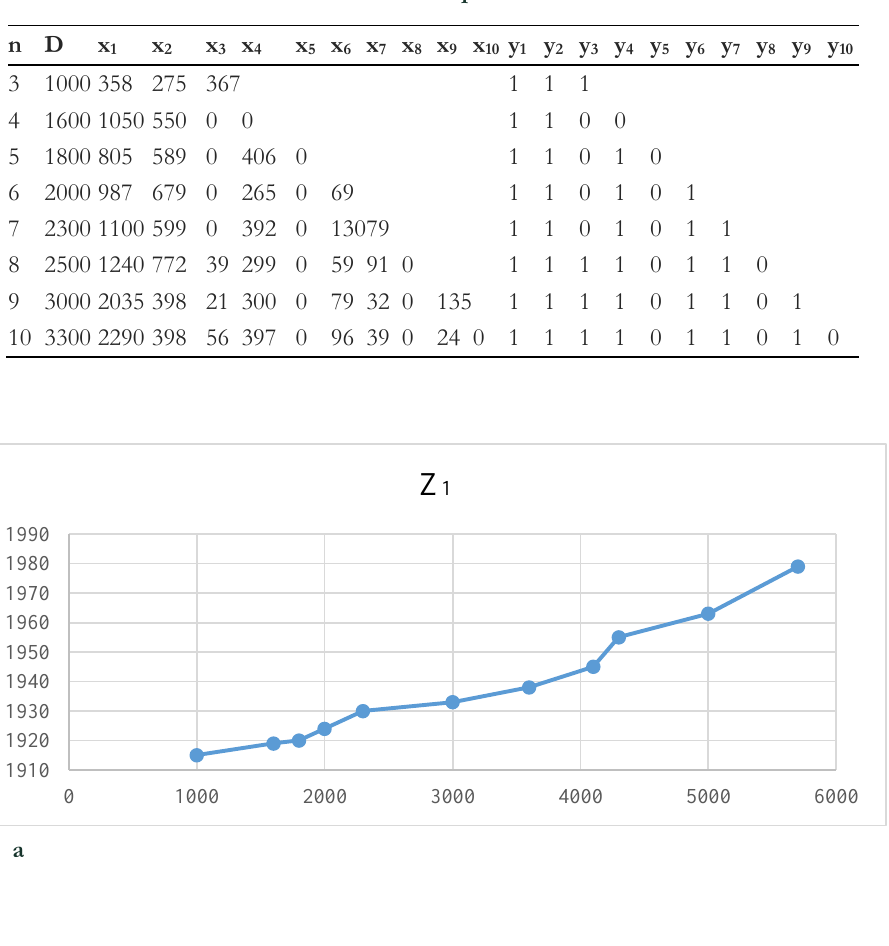
Table 3. The effect of D and n parameters on decision